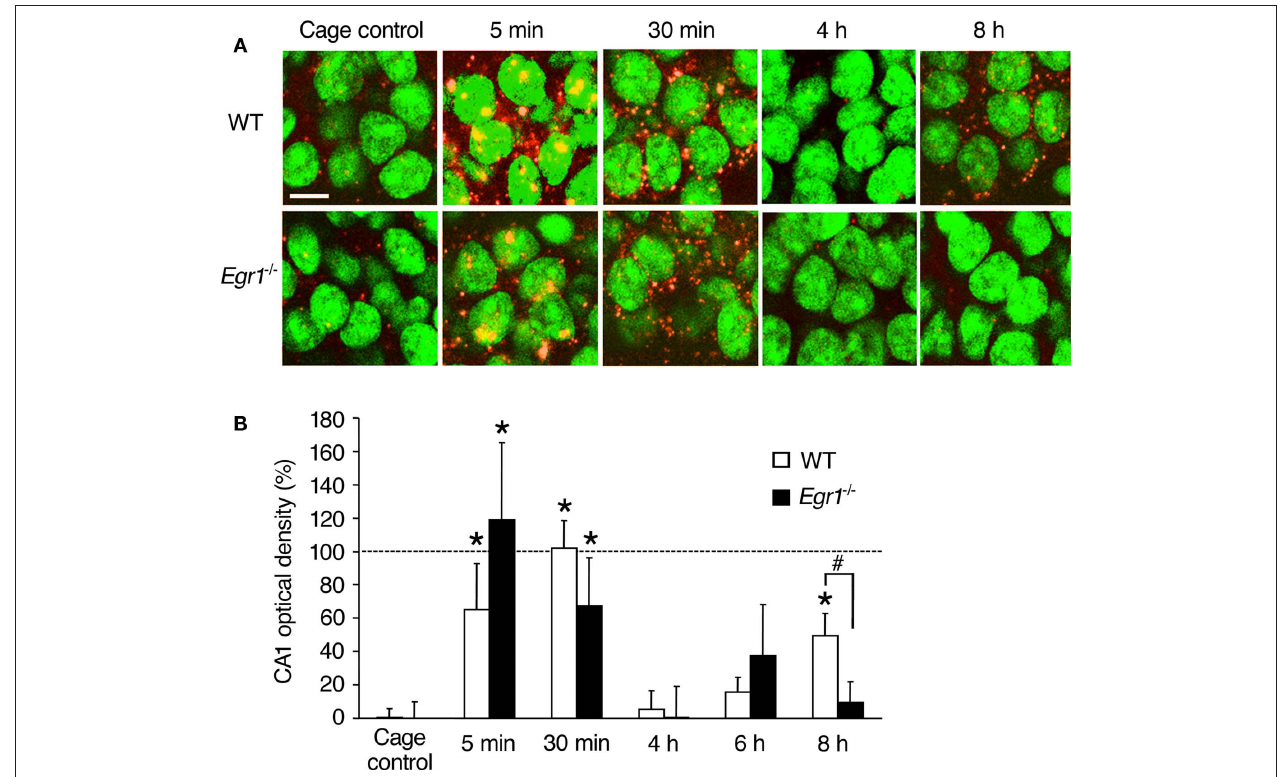
after ECS. Scale bar, 10 μm. (B) Optical density of Arc mRNA signal in CA1. After initial Arc mRNA induction, the level of expression returns to baseline by 4–6 h, and a second wave is observed 8 h after ECS. This second wave is not observed in Egr1 − / − mice. Error bars in this and subsequent figures indicate SEM. *Different from CCs of the same genotype, at least p < 0.05. #Difference between genotypes, p < 0.05. Dashed line indicates 100% (normalized to WT